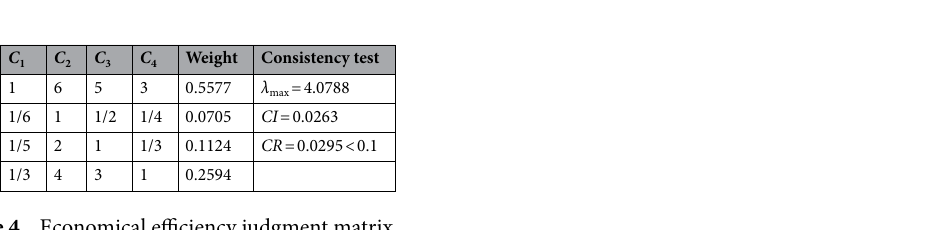
Table 4. Economical efficiency judgment matrix.